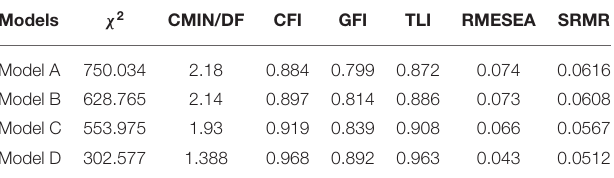
TABLE 3 | Model fit indices for four rounds of modifications.